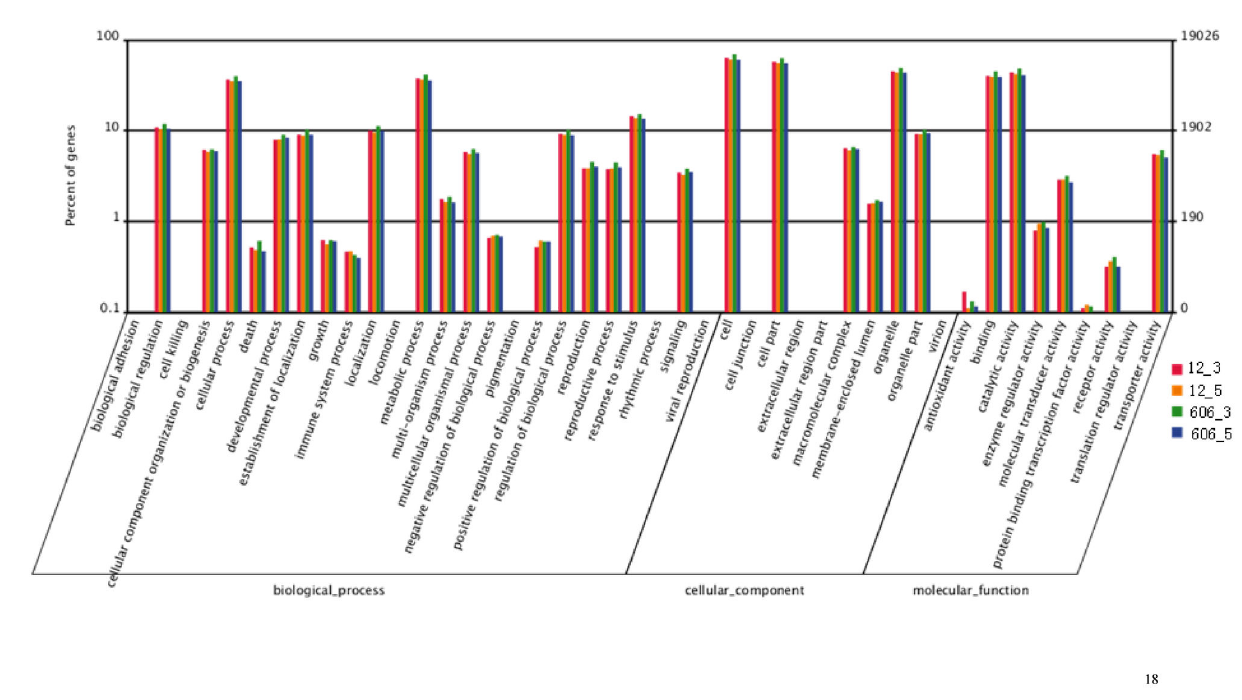
Figure 2. A histogram of unigene ontology classification. The results are summarized in three main categories: biological processes, cellular components and molecular functions. The right y-axis indicates the number of Unigenes in a particular category. The left y-axis indicates the percentage of a specific category of Unigenes in that main category. doi: